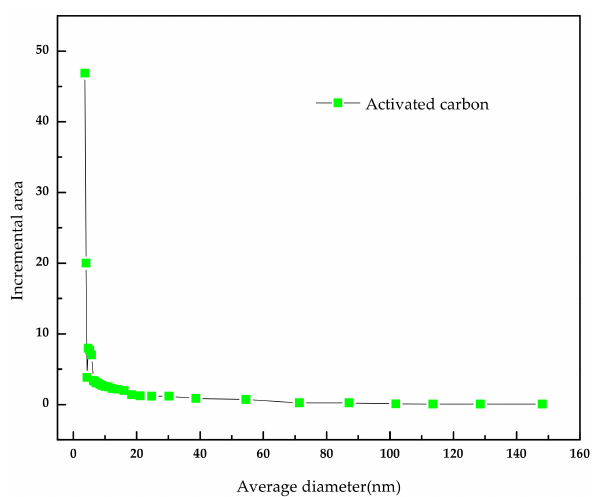
Figure 6. Activated carbonpore area vs. average diameter.